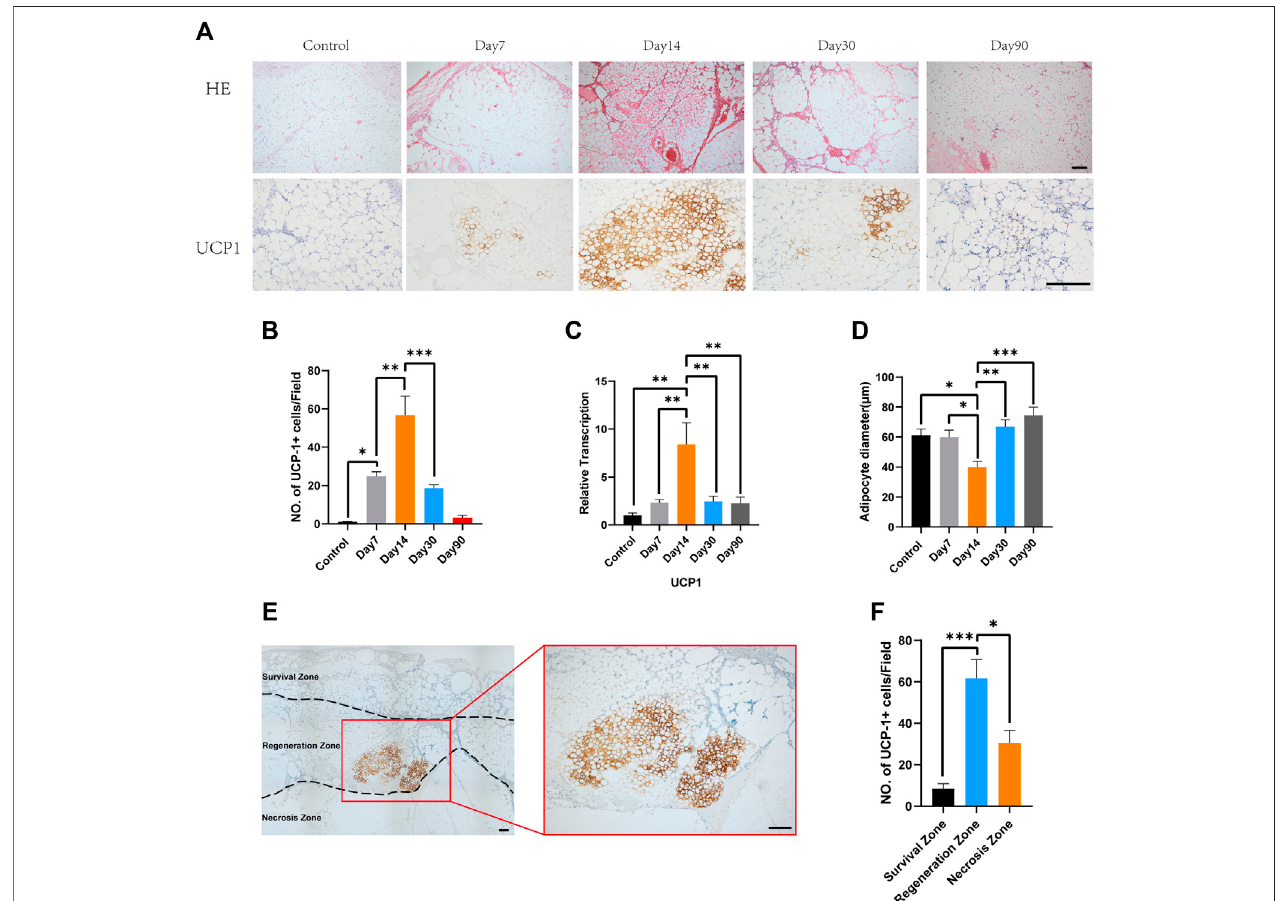
FIGURE 1 | Time course of the accumulation of beige adipocytes in the center of fat grafts. (A) Fat grafts on day 14 contain smaller adipocytes and more multilocular adipocytes and show strong immunostaining for uncoupling protein (UCP)-1. On days 7 and 30, there were more unilocular adipocytes and fewer UCP-1- positive fat cells, and still fewer on day 90. Presented fi gures were from the same zone of each grafts. (B) Beige cell counts at the various time points. (C) Expression of Ucp1 on days 7, 14, and 30. (D) On day 14, mean adipocyte diameter was lower than on day 7, 30 and 90. (E) Representative photomicrograph of UCP1 immunostaining, showing beige adipocytes in the “ regeneration zone ” of a graft. (F) Beige cell count in survival zone, regeneration zone and necrosis zone. (* p < 0.05; ** p < 0.01;*** p < 0.001). Scale bar = 100 μ m.